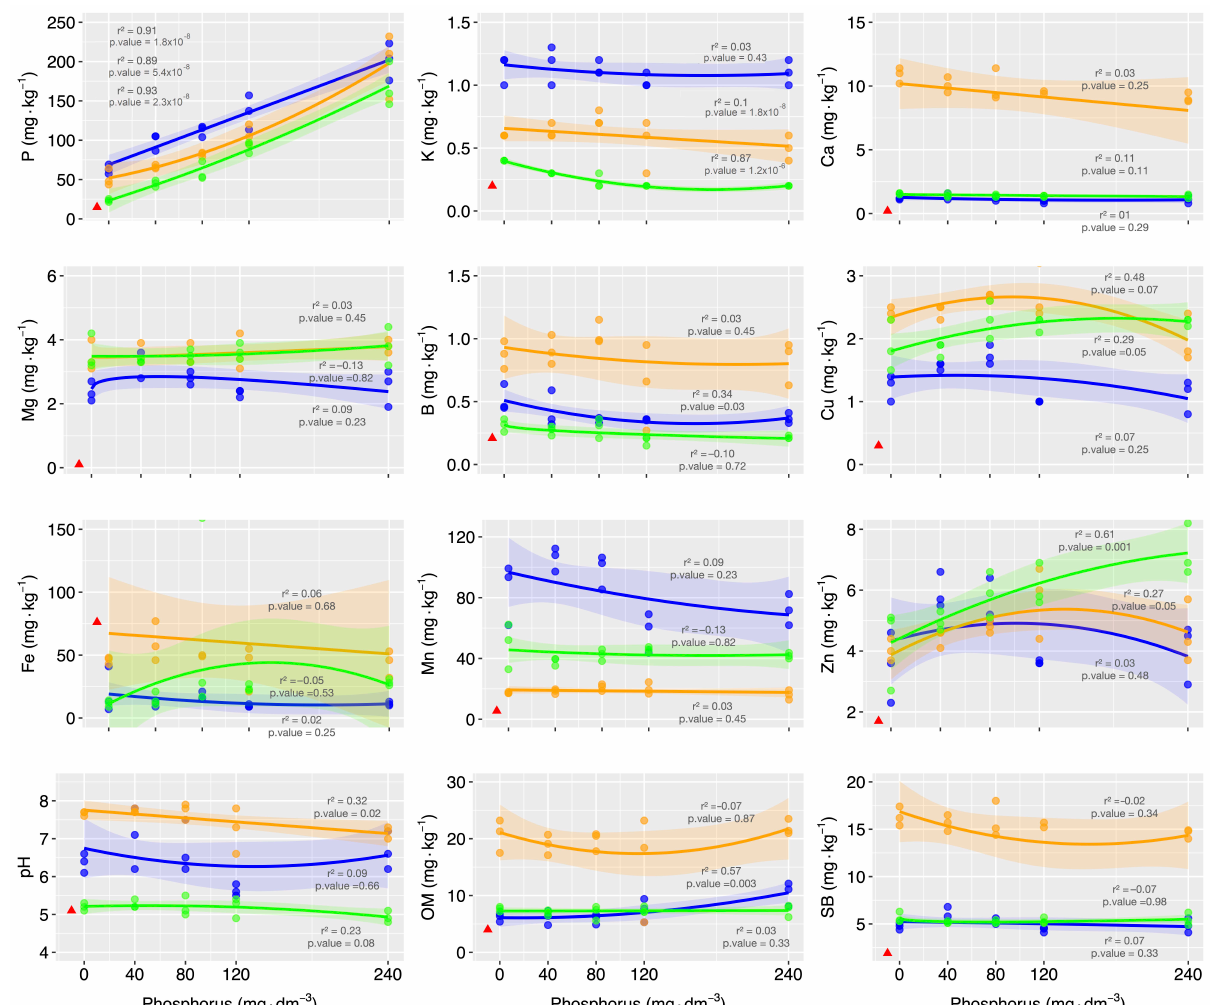
Figure 1. Properties of the Fe mining soil as a function of the application of biochar (blue) or compost (orange) and without the application of biochar or compost (green). The red triangle represents the Fe mining soil properties before D. apurensis cultivation and before